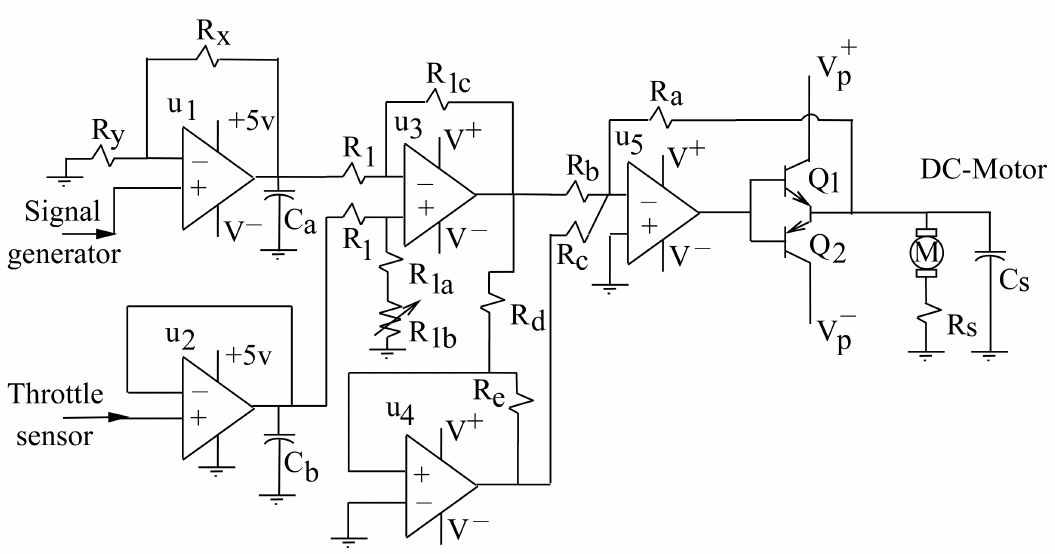
Figure 3. Circuit realization of the stated controller approach. The parameters used are: R y = 1.5 k Ω , R x = 4.6 k Ω , R 1 = 10 k Ω , R 1 c = 20 k Ω , R 1 a = 8.2 k Ω , R 1 b = 10 k Ω (potentiometer), R d = 330 Ω , R e = 1 M Ω , R b = 330 Ω , R c = 220 Ω , R a = 22 k Ω , R S = 1 Ω (power resistance), C S = 10 pF, C a = 1 µ F